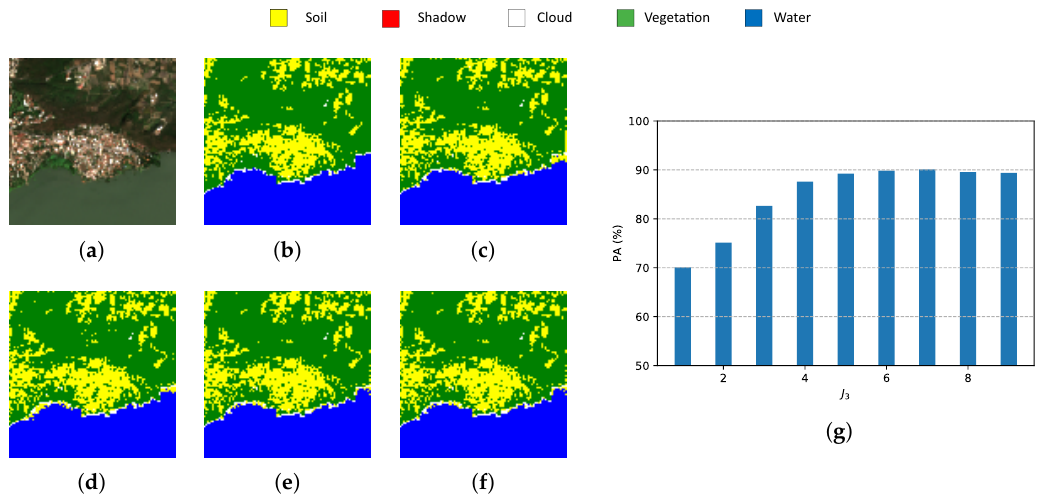
Figure 10. Qualitative results testing a scene of interest with abundant vegetation, and presence of shadows and clouds. ( a ) Original true color scenario of 128 × 128 pixels, in Central Europe: ( b ) five classes semi-manually labeled ground truth of the MSIs, ( c ) classification with an unsupervised normalized difference index (NDI) fusion algorithm, and ( d ) output prediction after 100 epochs in the FCN used for this work without data compression. ( e ) PCA-FCN framework output; ( f ) prediction of the whole framework HOOI-FCN proposed in this work; and ( g ) PA behavior of the HOOI-FCN versus number of tensor